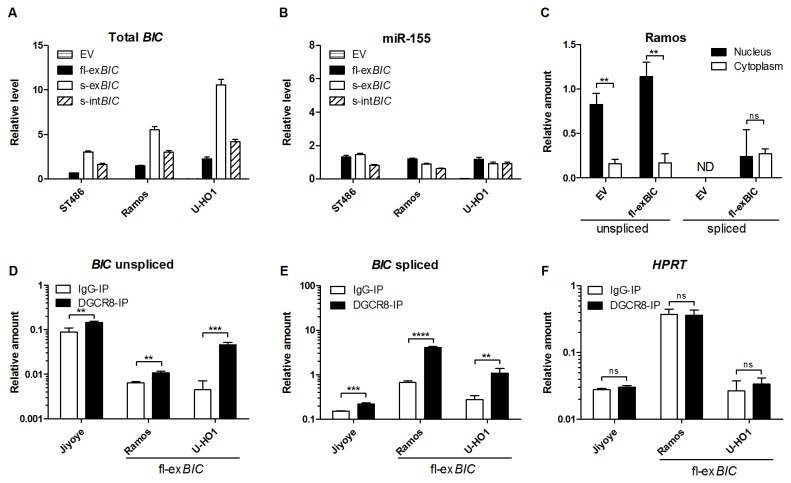
Processing and cellular localization of exogenous BIC transcripts.Levels of total BIC (A) and miR-155 (B) determined upon overexpression of the three constructs and empty vector (EV) in ST486, Ramos and U-HO1 cells. For the three BIC overexpression constructs, the increase in total BIC was variable and the highest levels were observed for the short BIC transcript containing the exon 2-derived 5’ pre-miR-155 flanking sequence (s-exBIC). However, miR-155 induction was similar for all BIC overexpression constructs. (C) The levels of spliced and unspliced BIC transcripts in nuclear and cytoplasmic fractions of Ramos EV and Ramos full-length spliced BIC (fl-exBIC). For both Ramos EV and fl-exBIC, unspliced BIC showed significantly higher (p<0.001) levels in the nucleus than in the cytoplasm. Spliced BIC was not detectable (ND) in Ramos EV. Upon overexpression of the fl-exBIC construct, spliced BIC transcripts showed similar levels in the cytoplasm and in the nucleus. Transcript levels in the cytoplasm and the nucleus were calculated relative to the total fraction and corrected for the amount of RNA per cell. Average of three independent experiments was presented. P values were determined by 2-way ANOVA and Bonferroni posttest (** p<0.01, ns - not significant). Relative amounts of unspliced (D) and spliced (E) BIC transcripts in DGCR8-IP compared to IgG-IP in Jiyoye, Ramos fl-exBIC and U-HO1 fl-exBIC cells. Endogenous unspliced, endogenous spliced and exogenous spliced BIC transcripts were significantly enriched in DGCR8-IP compared to IgG-IP. (F) No enrichment of HPRT transcript was observed in DGCR8-IP. Amounts were calculated relative to tRNA-Lys levels. P values were determined by Student’s t-test (** p<0.01, *** p<0.001, **** p<0.0001, ns - not significant).